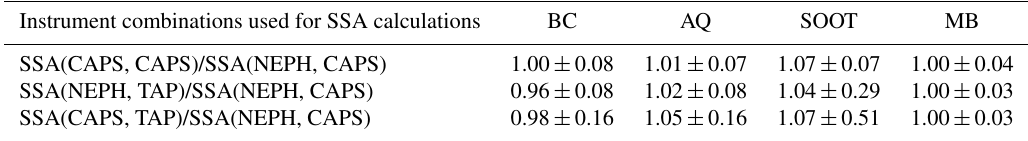
Table 10. Ensemble instrument-to-instrument measurement ratio averages and standard deviations for different instrument combinations used to derive SSA values at 630nm wavelength using SSA(NEPH, CAPS) as a reference. Instrument combinations used for SSA calculations